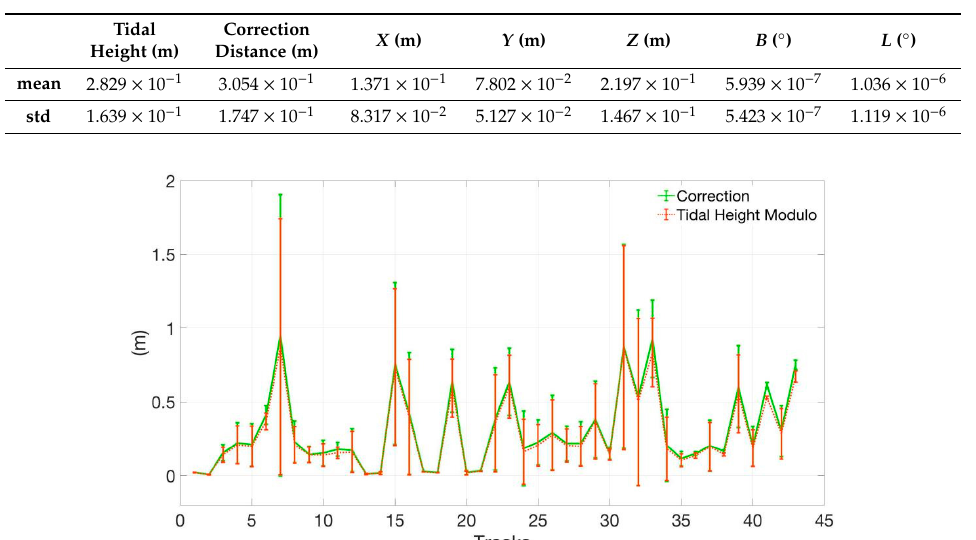
Table 1. Tidal height modulo and the corresponding tidal positioning correction by the OTCP method.